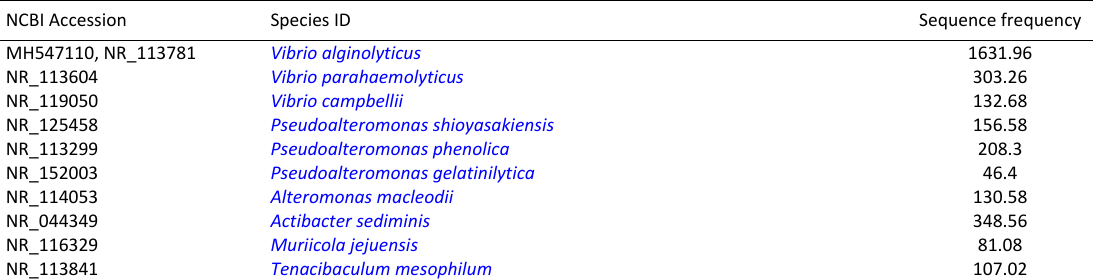
Table 2: Amplicon Sequence Variants (ASV) present in 50% of all sediment samples